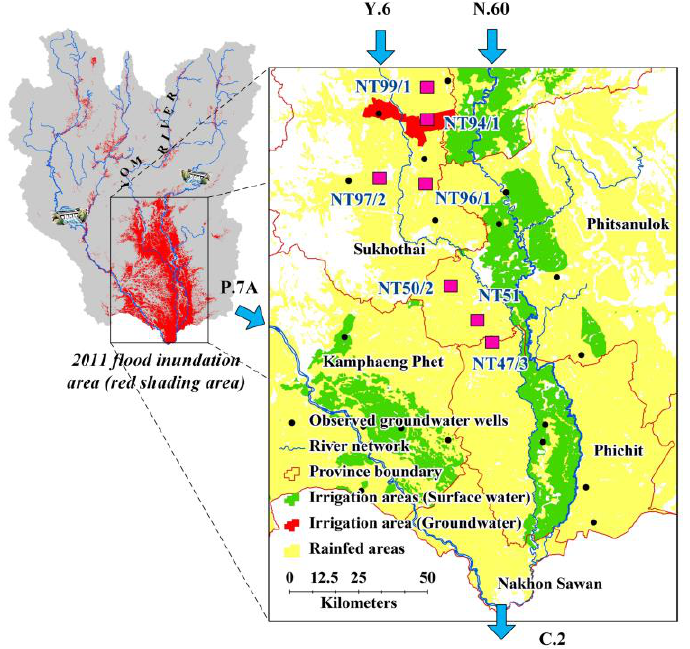
Figure 5. The UCP’s flood-prone, agricultural areas, and observation wells along the Yom River (pink squares).